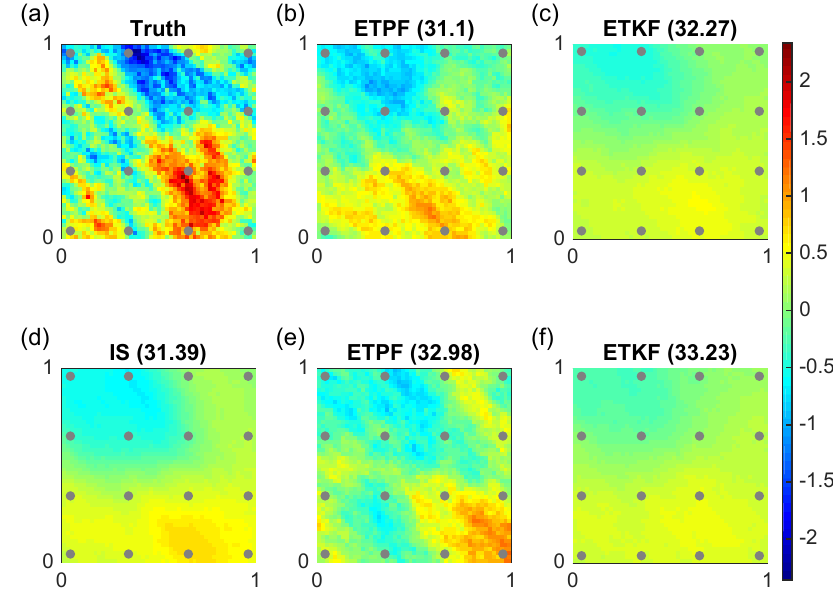
Figure 13. Same as Fig. 8 but using only three leading modes in the KL